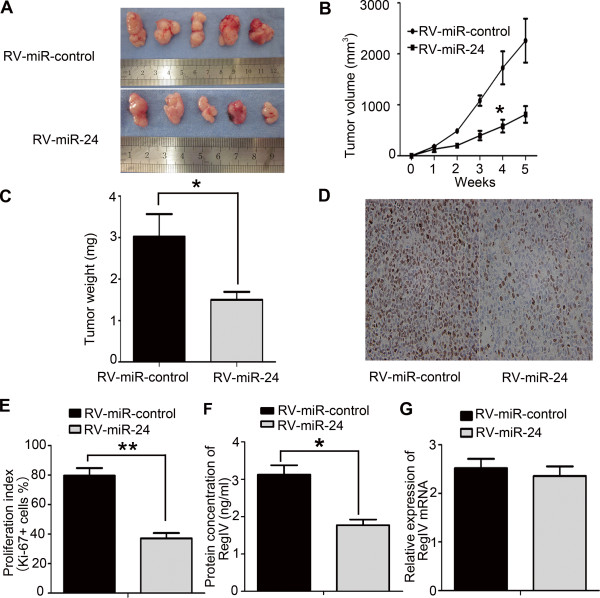
miR-24 inhibited tumorigenicity and proliferation in vivo. (A) Photograph of tumors derived from RV-miR-24 or RV-miR-control cells in nude mice. (B) Growth kinetics of tumors in nude mice. Tumor diameters were measured every 7 days. The volume of the nude mice indicated by bars, S.D. (*P < 0.05). (C) The average weight of tumors in nude mice. Data are shown as means ± S.D. (*P < 0.05). (D) Representative photographs of immunohistochemical analysis of Ki-67 antigen in tumors of nude mice (original magnification, 200×). (E) Representative proliferative index of tumors in RV-miR-24 and RV-miR-control nude mice. Data are shown as means ± S.D. (**P < 0.05). (F) Expression levels of RegIV in tumor tissues of nude mice. Data are shown as means ± S.D. (*P < 0.05). (G) Expression levels of RegIV mRNA in tumor tissues of nude mice (P > 0.05). Data are shown as mean ± S.D. of three independent experiments.